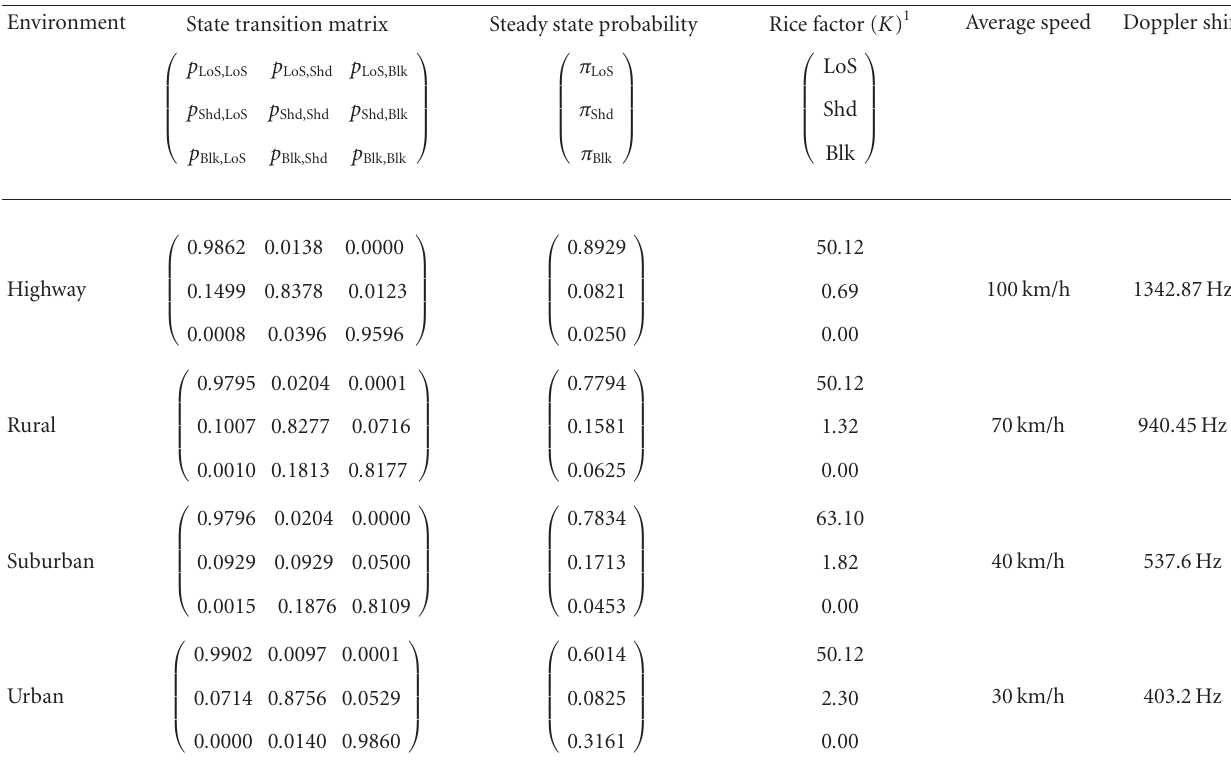
Table 1: Ku-band land vehicular channel model parameters [4,